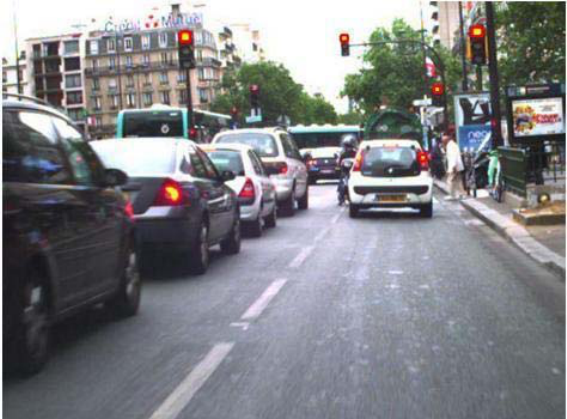
Fig. 5. Result image with bounding box of the candidate regions after filtering based on border properties. Notice that there is only one false alarm which is the taillight of the car. Still, no candidate regions of traffic lights are